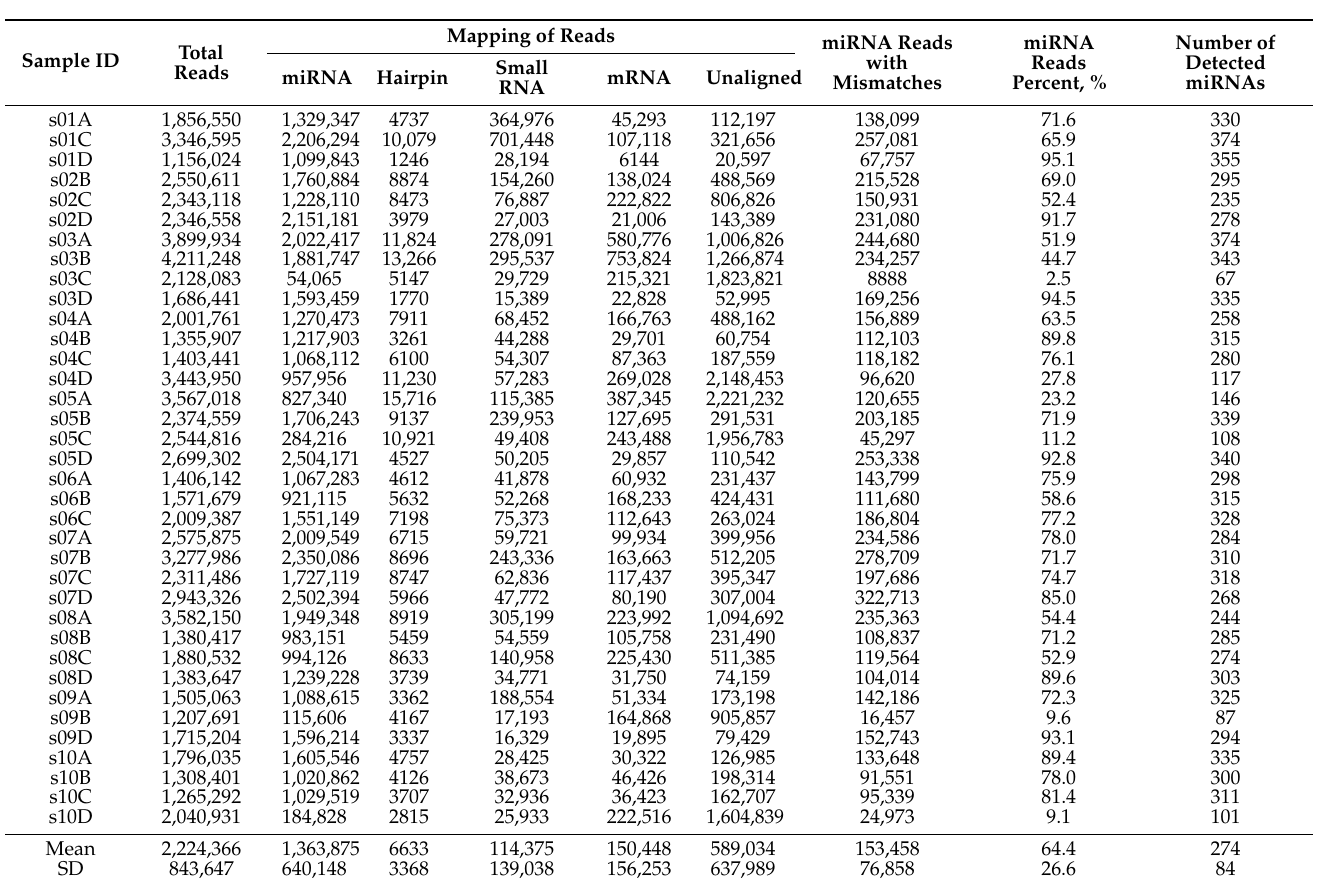
Table A2. General data of miRNA sequencing analysis using the QuickMIRSeq pipeline. SD, standard